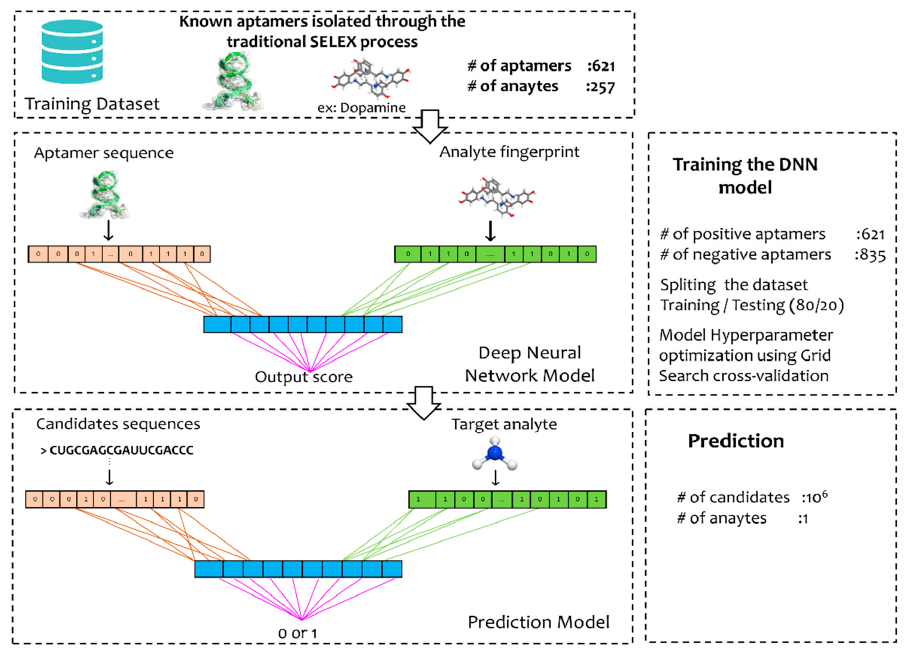
Figure 2. Deep Smart-SELEX model with CNN blocks to learn from aptamer sequences targets MACCS fingerprints and physicochemical properties.